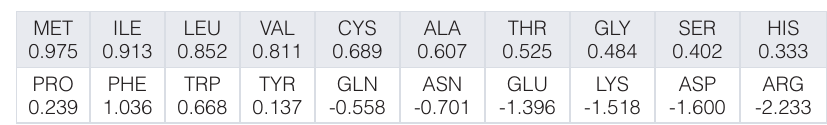
Table 2. Hydrophobicity scale taken from 17 .